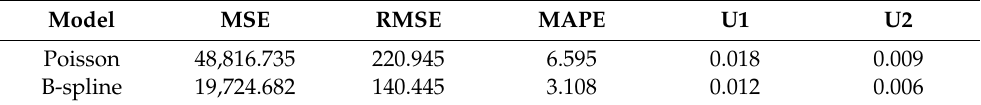
Table 1. Two-year forecast accuracy using an out-of-sample training-test validation set (minor numbers indicating greater forecast